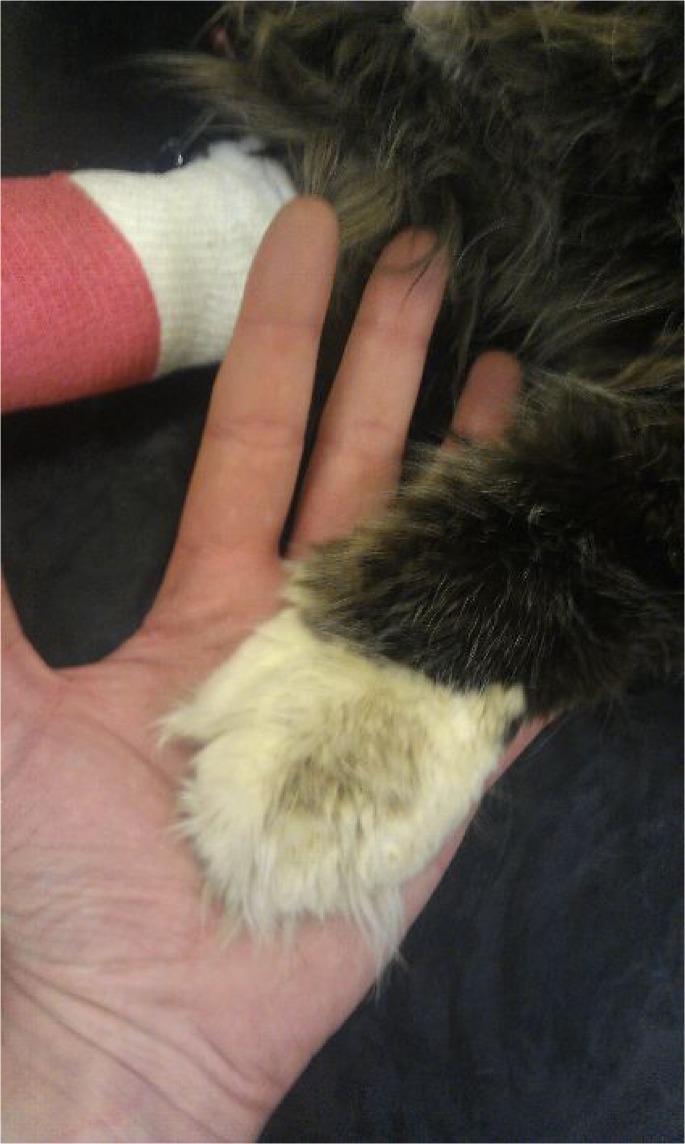
Paws of an overtly acromegalic cat.This figure shows a cat with confirmed acromegaly demonstrating so-called clubbed paws; enlargement of the paws due to acromegaly.